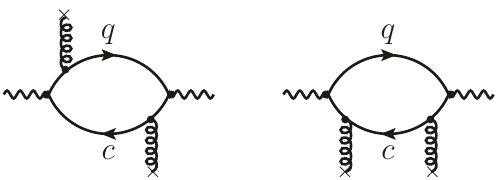
Figure 1 . The diagrams with nonvanishing contributions to the gluon condensate term in the OPE of the two-point correlators. The crossed lines denote vacuum